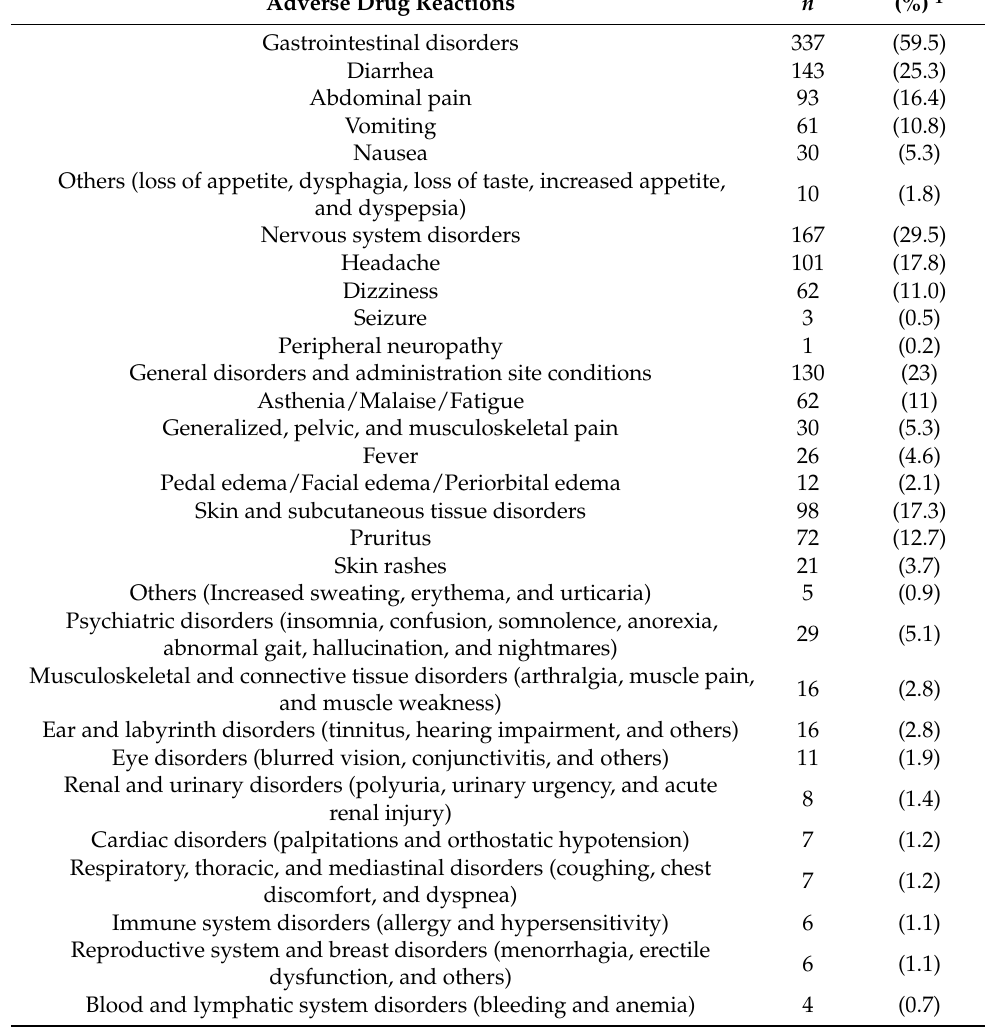
Table 3. Types of antimicrobial-related ADRs in individuals ( n = 566) according to the MedDRA system organ classification reported to the VigiFlow in Sierra Leone during